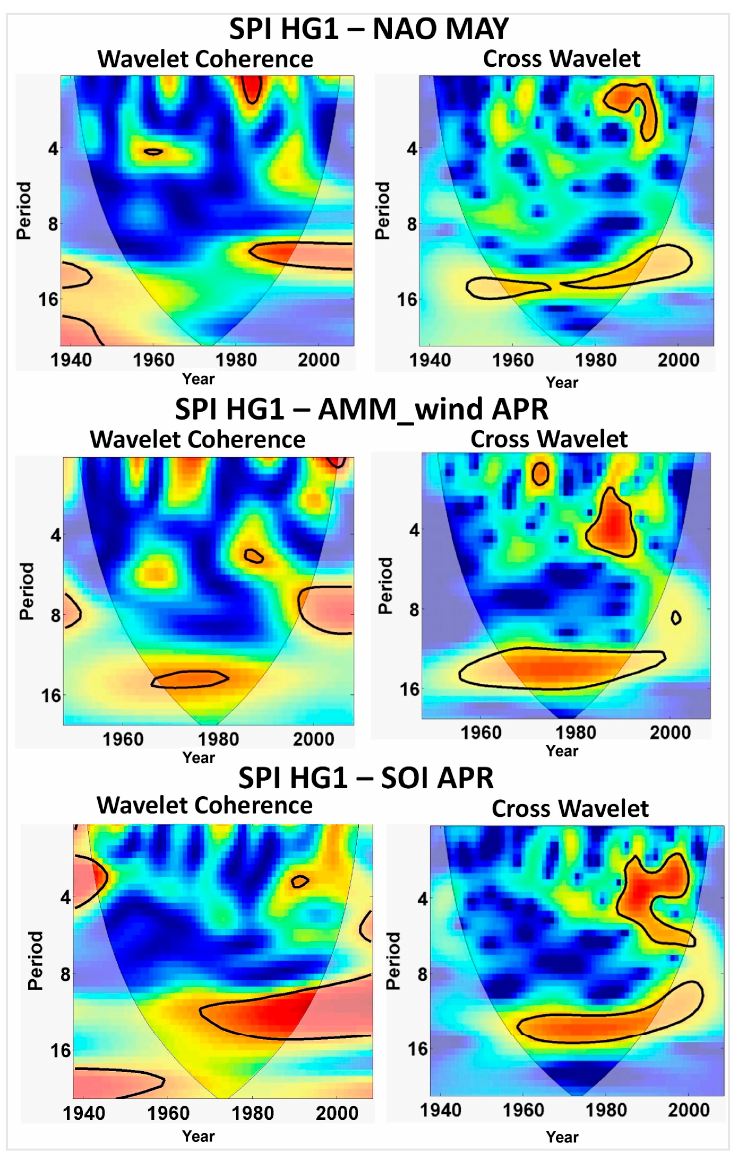
Figure 5. Wavelet Coherence ( left column ) and Cross Wavelet Transform ( right column ) between climate indices and SPI3* at HG1 from 1938 to 2008 (except AMM, from 1950 to 2008). The thick black contours represent 95% of confidence level.